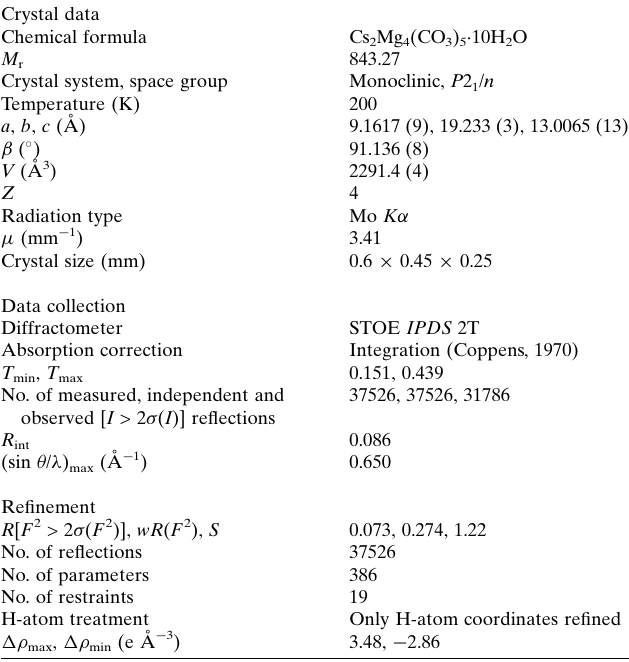
Table 2 Experimental details. Crystal data Chemical